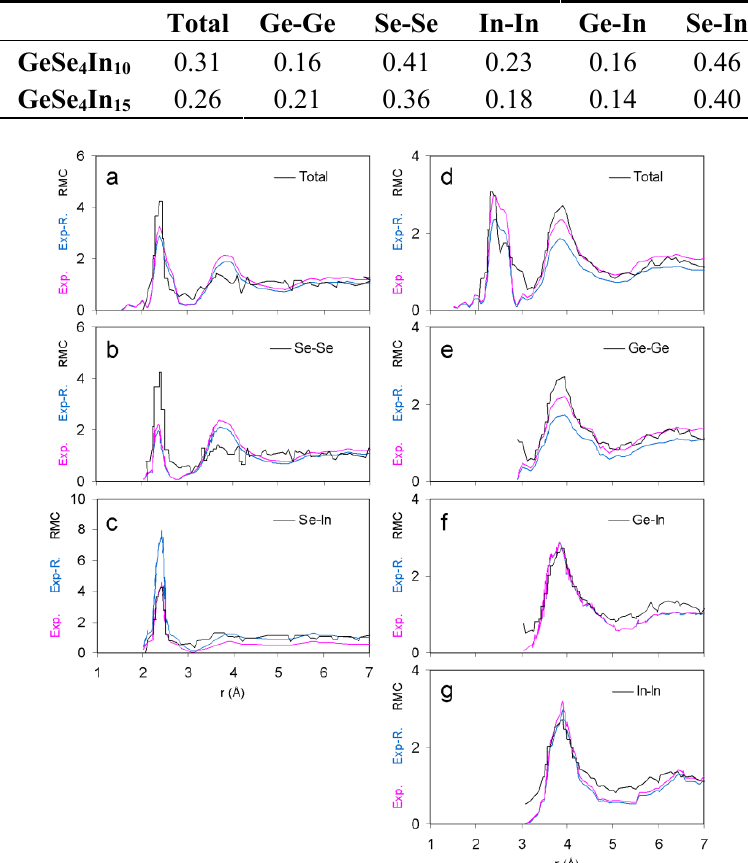
Table 2. Total and partial working residuals, R w , of the RMC goodness of fit for the GeSe 4 In 10 and GeSe 4 In 15 systems.